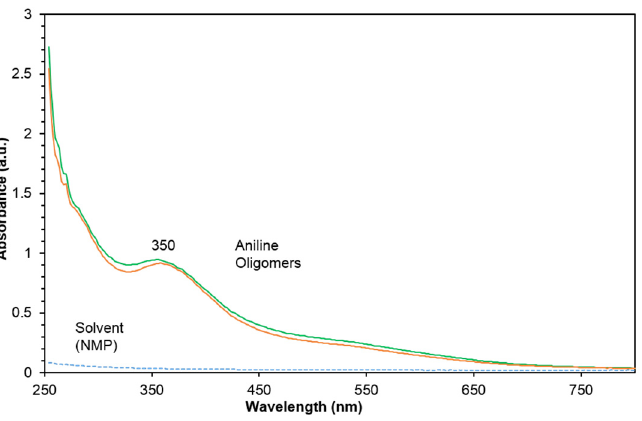
Figure 3. UV-vis spectrum of two batches of PANI (green and orange) and NMP (broken